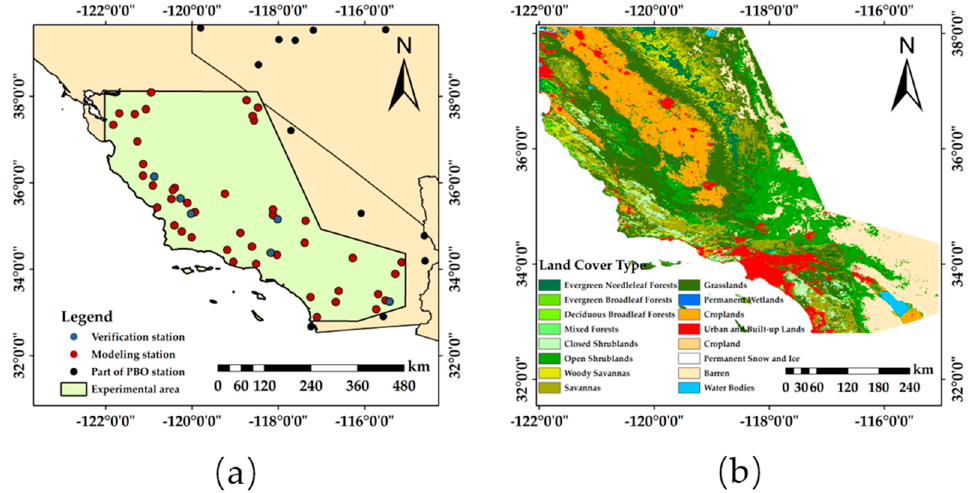
Figure 5. Overview of the study area for this study (32 ◦ N–39 ◦ N, 114 ◦ W–123 ◦ W), ( a ) experimental area in green, modeling stations in brown, and validation stations in gray; ( b ) land cover type of the experimental area.